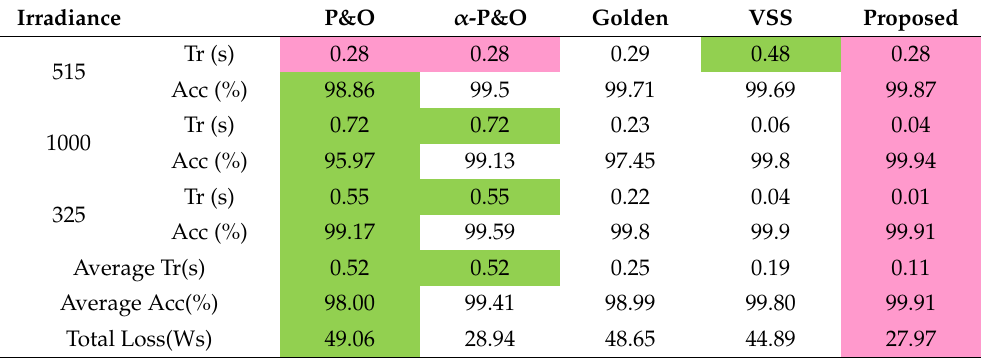
Figure 9. Simulated tracking waveforms of five compared MPPT methods under varying irradiation condition. Table 4. Simulated results of five compared MPPT methods under varying irradiation